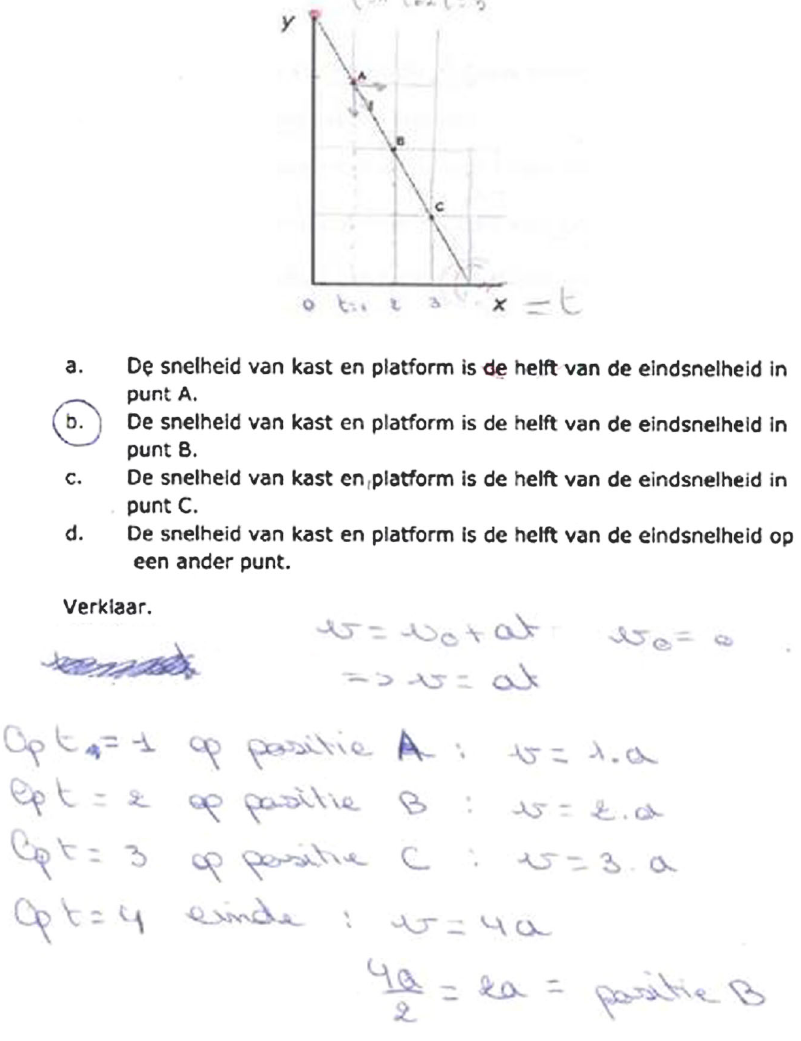
FIG. 5 (color online). Student answer mistaking the y ð x Þ graph for a y ð t Þ